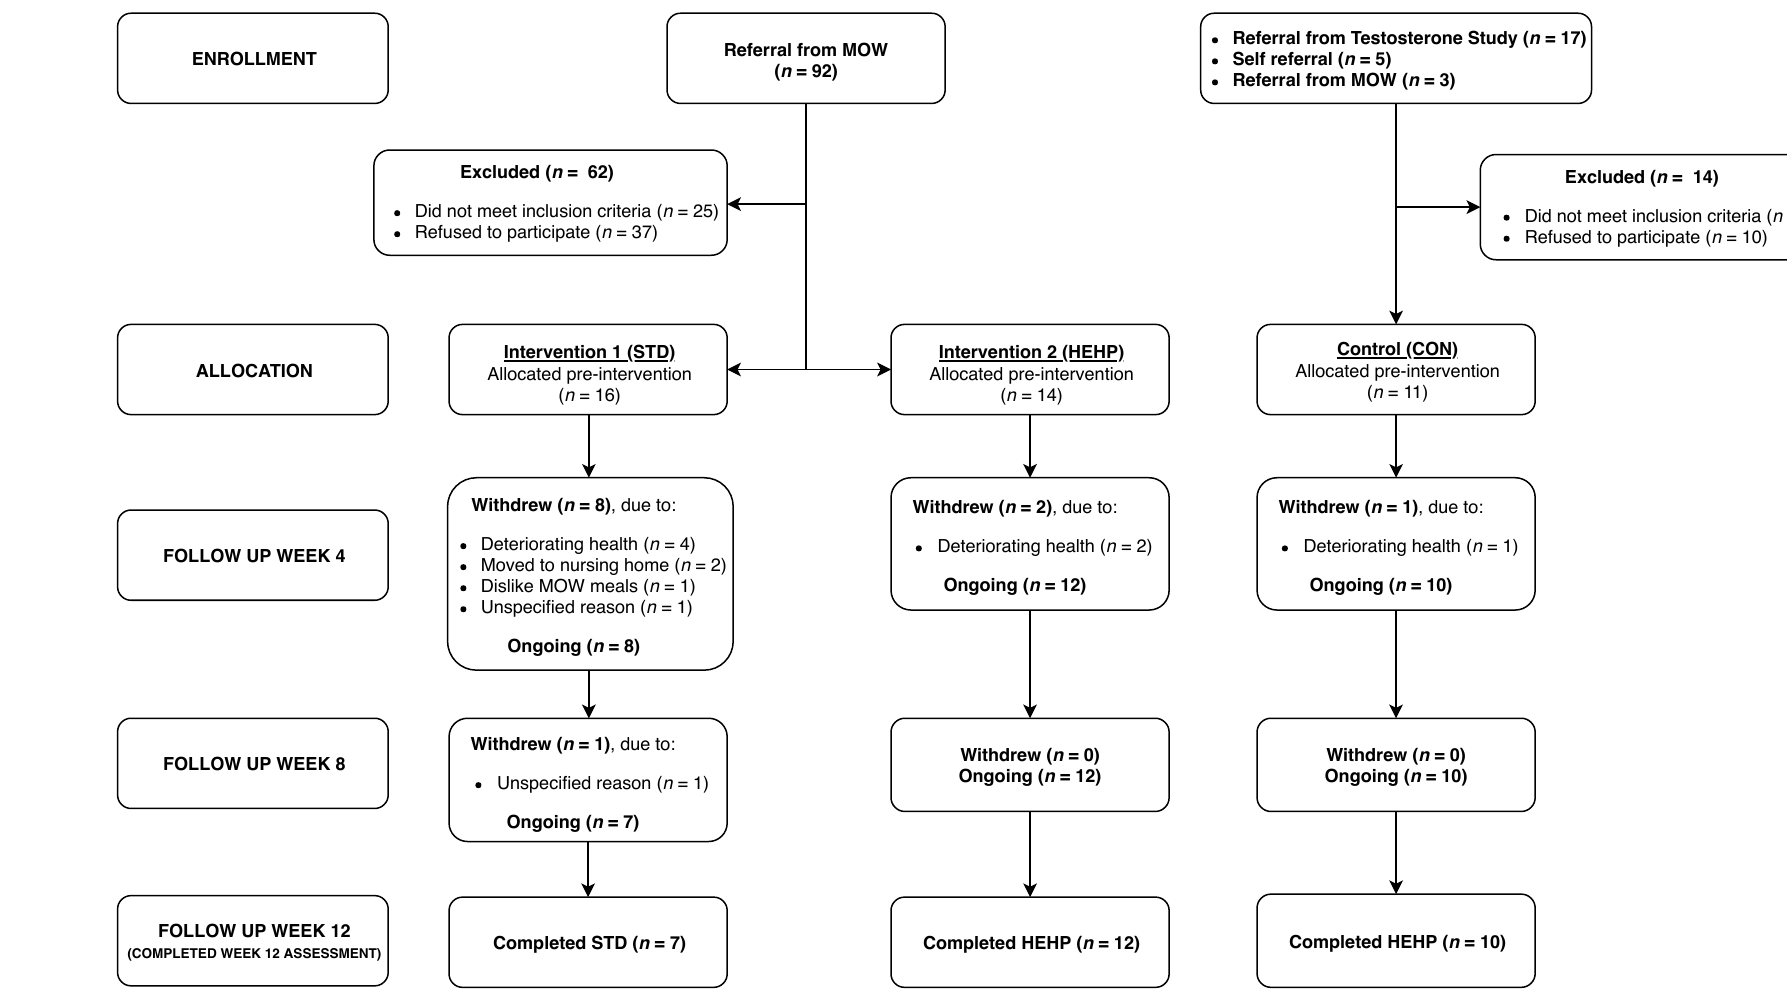
Figure 1. Flowchart of participants through the